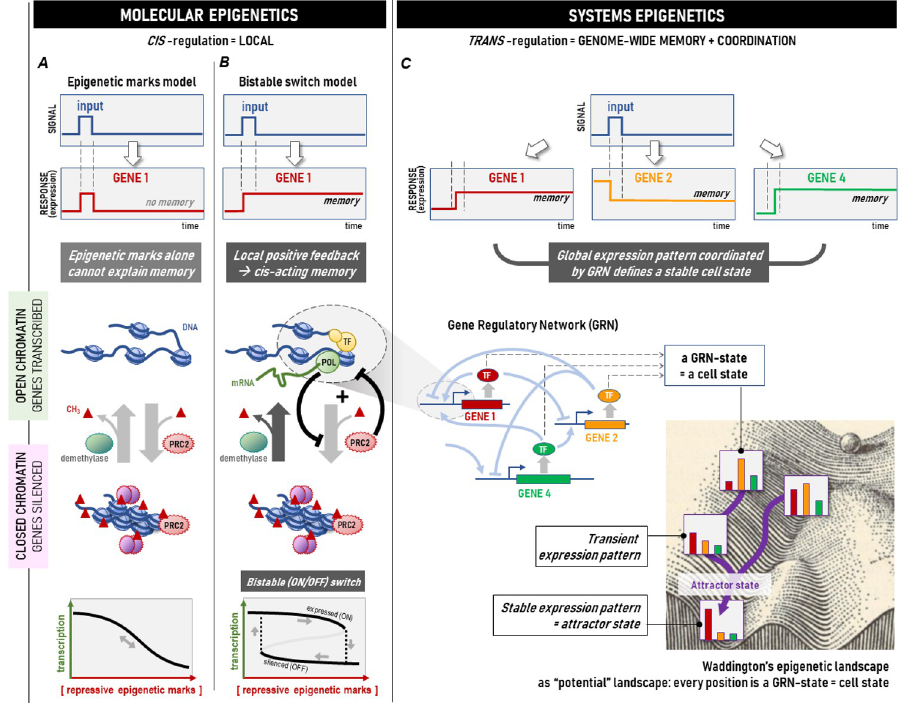
Fig 1. Two schools of “epigenetics”: molecular epigenetics versus systems epigenetics. AU : PleasenotethattheabbreviationlistinFig 1 hasbeenupdated : Pleasecheckandverifythatallentriesarecorrect : New studies suggest that local epigenetic regulation by adding or removing epigenetic marks, here exemplified by methylation (red triangle; panel A), is converted to a local bistable (ON-OFF) switch (the cis -acting memory; panel B), affording memory but only for 1 gene locus. To produce stable gene expression patterns (shown here as genes 1, 2, and 4), trans -regulation, embodied by the GRN (panel C) is required. The dynamics of the GRN as a whole are epitomized by Waddington’s “epigenetic landscape” [3], in which valleys represent stable “attractor states”. GRN, gene regulatory network; POL, polymerase; PRC2, Polycomb complex PRC2; TF, transcription